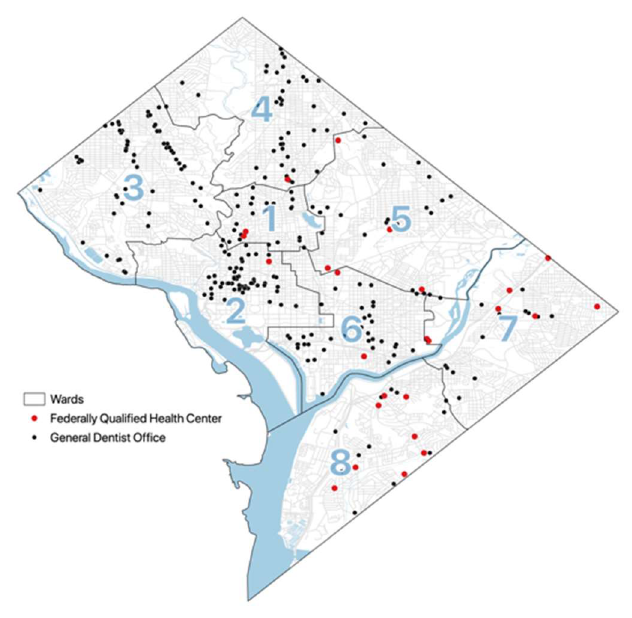
Figure 1. Map of Dental Services in Washington DC (adapted from Davis et al., 2022).